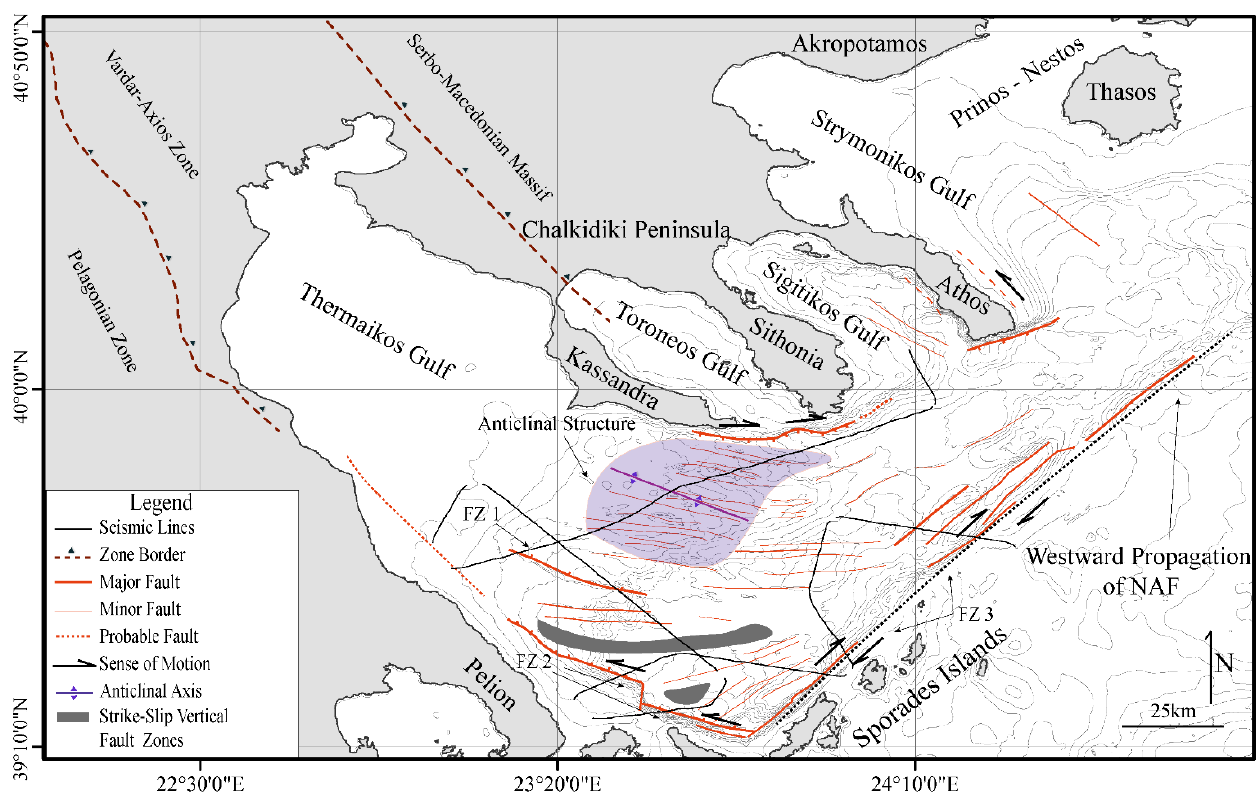
Figure 2. Simplified map of active tectonic lineaments in the North Aegean Trough, modified after Ferentinos et al. [35], Papanikolaou et al. [25], and Sakellariou et al. [18]. The kinematics direction is based on the cited references, while the three fault zones (FZ) deduced from the analysis of the seismic data are indicated. The purple-shaded area covers the major anticlinal structure observed in the seismic profiles. Gray-shaded areas constrain the strike-slip vertical fault zones identified by Papanikolaou et al. [25] and are further correlated in the present study. The location of the seismic lines is also shown.